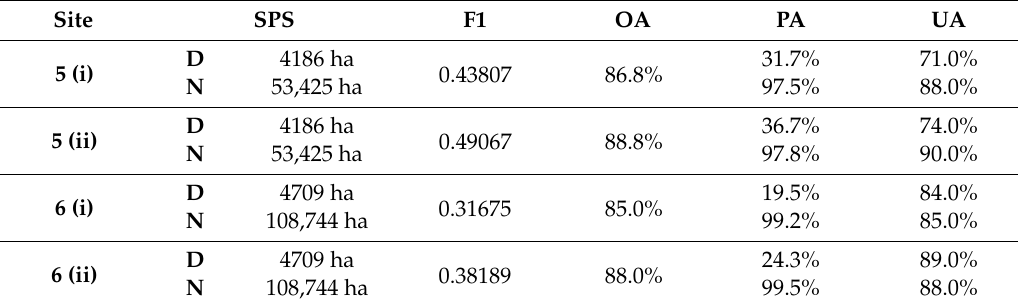
Table 4. Accuracy values of the ∆ rNBR products (0.03 threshold) derived for the two HR study sites to analyze topographic effects; (i) refers to accuracy assessment type i; (ii) refers to assessment type ii; D = disturbance stratum; N = no disturbance stratum; SPS = stratum population size; F1 = F1 score; OA = overall accuracy; PA = producer accuracy; UA = user